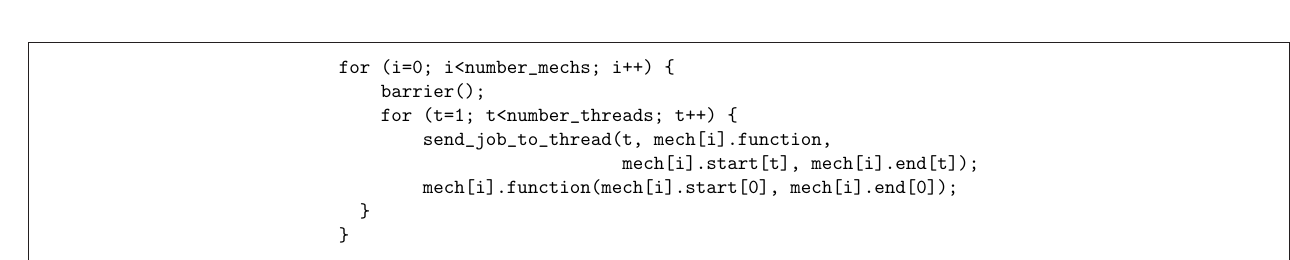
FIGURE 5 | Mechanism type level parallelization. Height of mechanism type bars indicates per-compartment complexity. Distribution of different mechanisms (height indicates complexity) across the cell is often spatially inhomogeneous. Here, computation of the mechanism instances on one specifi c compartment is often performed by different cores and requires synchronizations after each mechanism type.